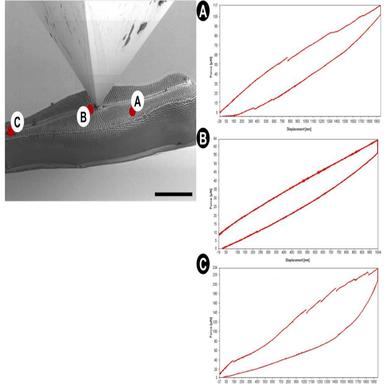
SEM image during in situ indentation with marked places of investigations. Indentations have been performed with (a) 2000 nm, (b) 1000 nm, (c) 2000 nm displacement.